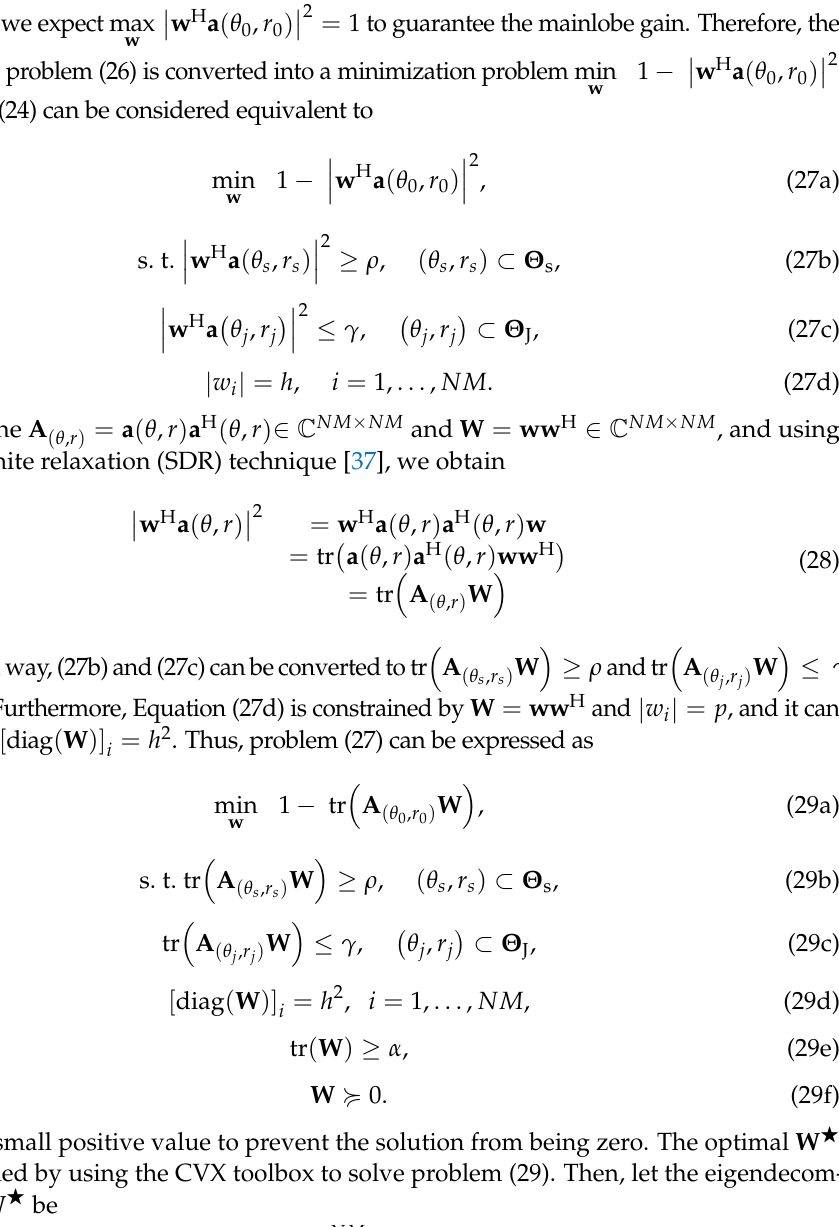
Algorithm 1. The computational complexity of the CMC algorithm is mainly